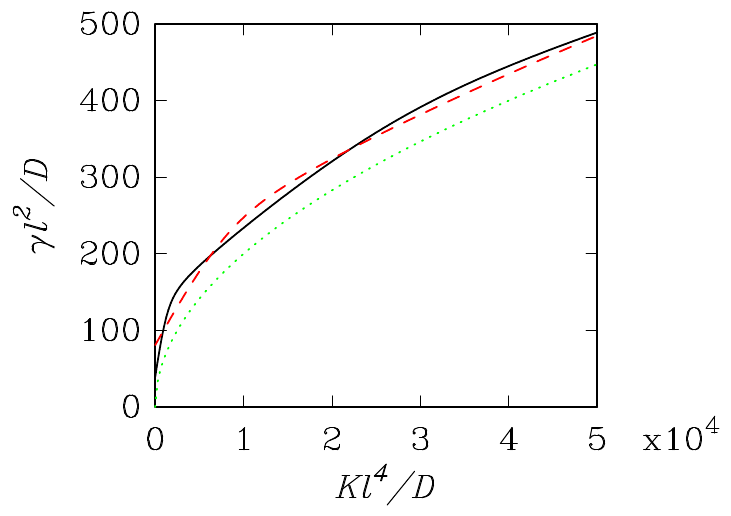
Figure 2. The homogeneous differential equation (Equation (16)) has non trivial solutions for values of the parameters outside the convex side of the curve (cid:13) = 2 The figure illustrates the relationship between the equation parameters for the fundamental bucking modes of even (solid-line curve) and odd (dashed-line curve) symmetries when the graphene ribbon is clamped along its two edges distant of l . The value of the critical tension at K = 0 are 39 : 48 D=l 2 and 80 : 76 D=l 2 for the symmetric and antisymmetric modes,